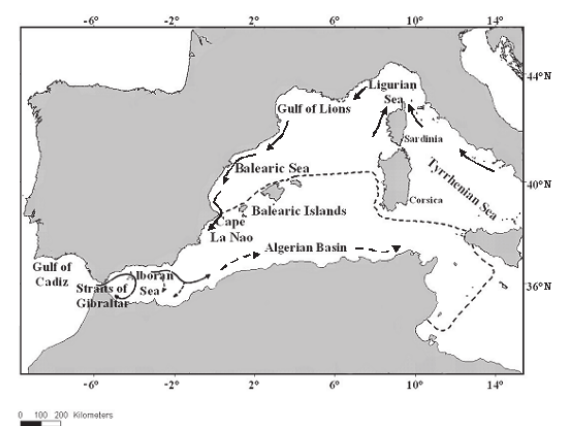
Fig . 1. – Basins within the western Mediterranean, the limit between the northern and southern regions (dashed line), and the prevailing currents in agreement with Millot (1999)